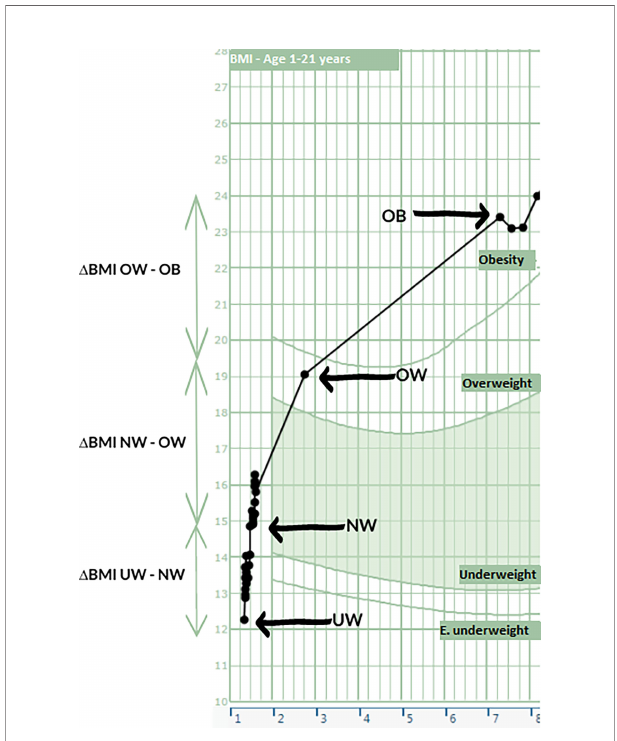
FIGURE 1 | Case of DS evolving into HO to support Table 2 . On the X axis the age is shown and on the Y axis the BMI. Various time points as displayed in Table 2 are shown